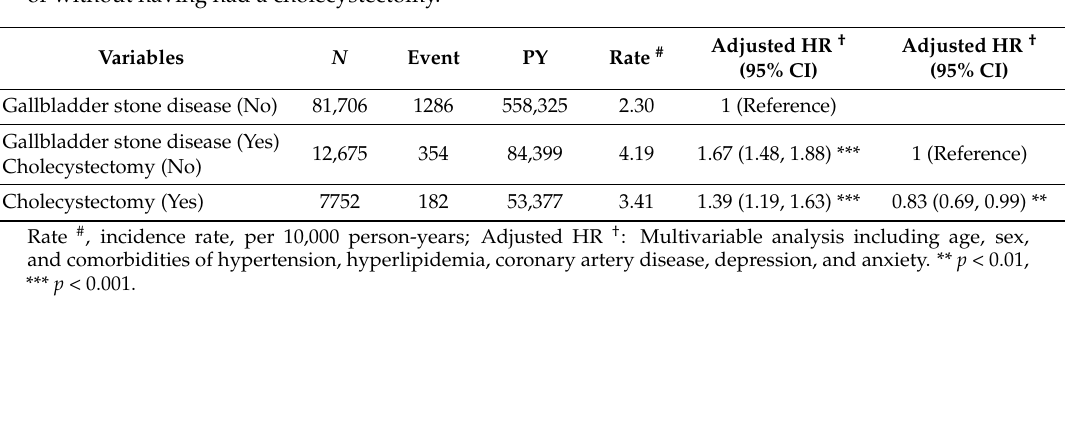
Table 5. Incidence and hazard ratio of migraine associated with gallbladder stone disease patients with or without having had a